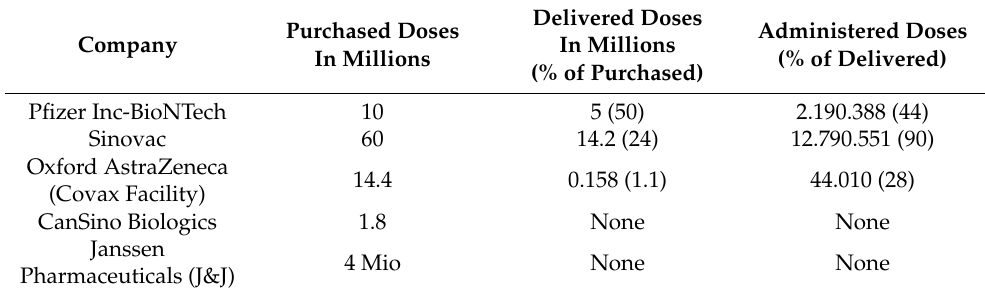
Table 2. Purchased quantities, supply volumes, and delivery status of vaccine doses as of 30 April 2021. Delivered Doses Administered Doses Purchased Doses In Millions Company (% of Delivered) In Millions (% of Purchased) Pfizer Inc-BioNTech 10